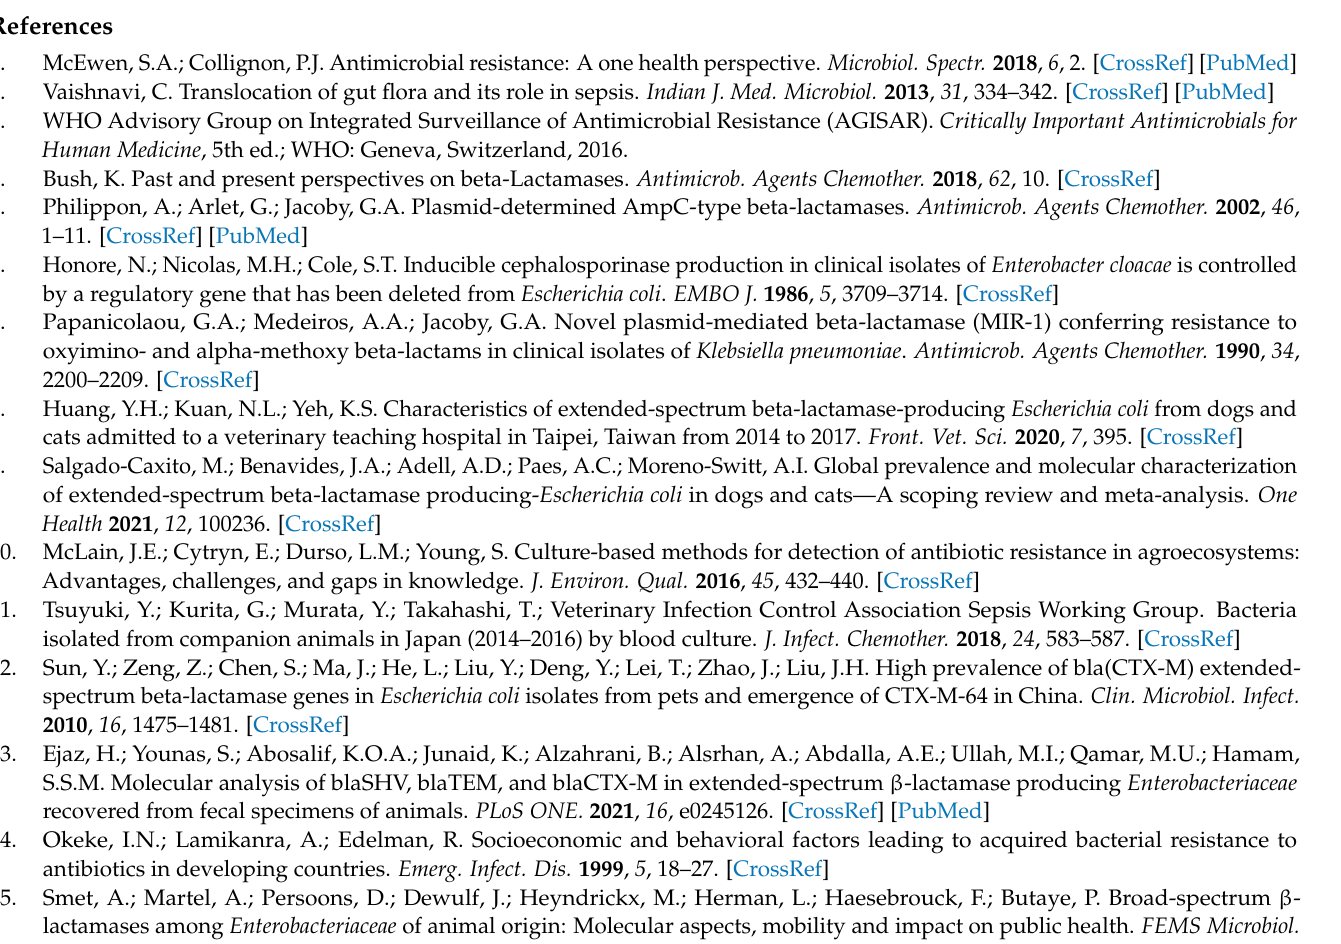
Table S1: Antimicrobial susceptibility test of the E. coli containing ESBL, pAmpC, both or neither. Table S2: Interpretive categories and breakpoints used in the present